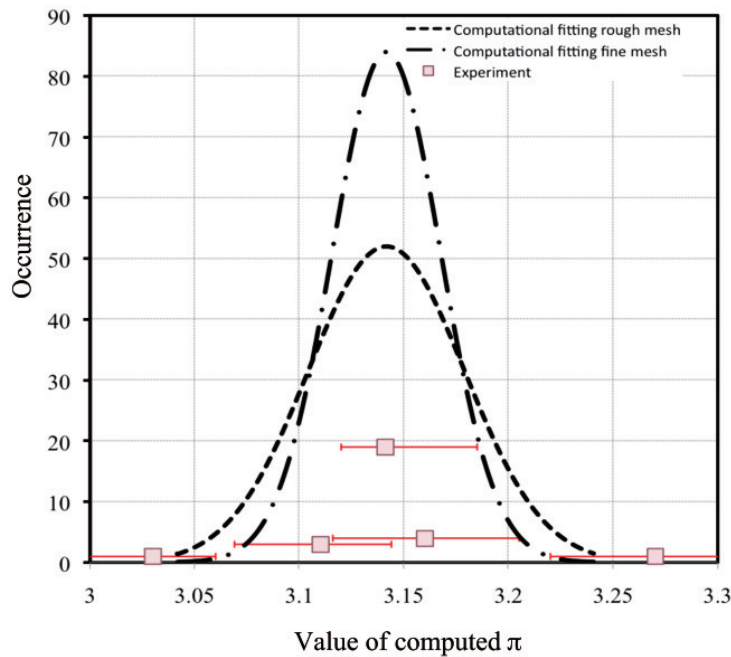
Figure 7. Experimental results using fracture mechanics data. The results are also compared with computational